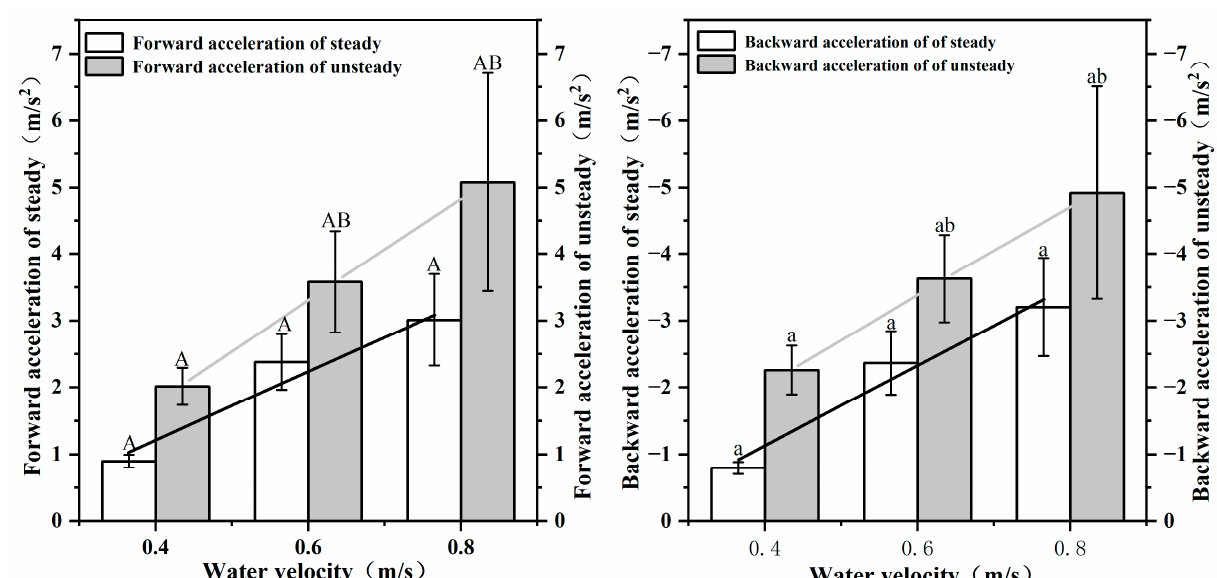
Figure 5. Relationship between forward/backward acceleration and water flow velocity in steady/unsteady mode of S. malacanthus swimming. Different upper cases indicate the significant the difference of water velocity in forward acceleration of steady/unsteady treatments; Different lower cases indicate the significant the difference of water velocity in backward acceleration of steady/unsteady